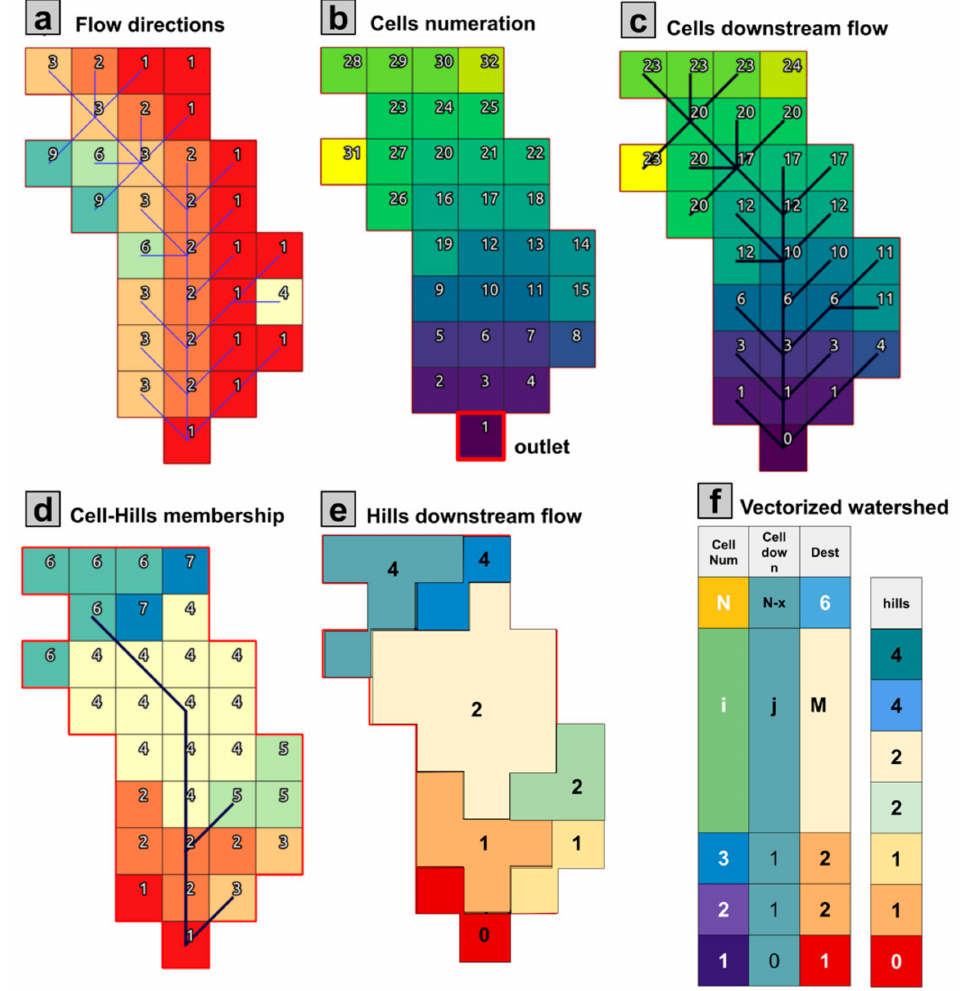
Figure 3. The base topological structure of a watershed in WMF. ( a ) Initial DIR map, blue lines denote directions, the colors represent the direction; ( b ) watershed cell numeration relative to the outlet cell, colors represent the cell number. ( c ) Cells downstream flow relative to the cell numeration, colors represent the cell number. ( d ) Cells membership to identified hills based on threshold area to determine network, colors represent each hill. ( e ) Hills downstream flow relative to the outlet hill, colors represent each hill. ( f ) Scheme of the vectorized properties of the watershed shown from panels ( b ) to ( e